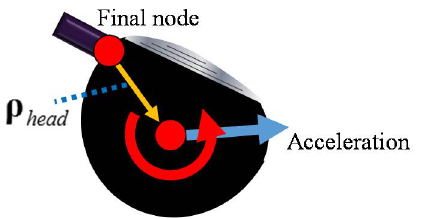
Figure 4. Head-torque is the combination of the grip acceleration and the position of the club head centroid. (cid:2251) (cid:3035)(cid:3032)(cid:3028)(cid:3031) is the vector for the direction from the final node of the shaft to the club head